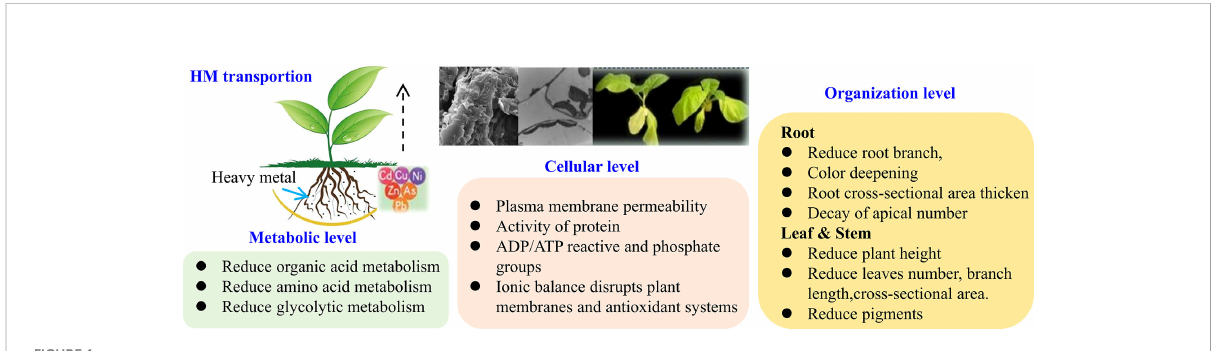
FIGURE 1 The effects of heavy metals for plant from metabolic, cellular, organization